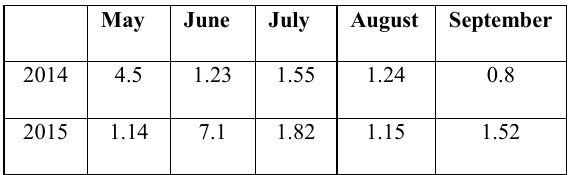
Table 4 Monthly values of rmse between final run product